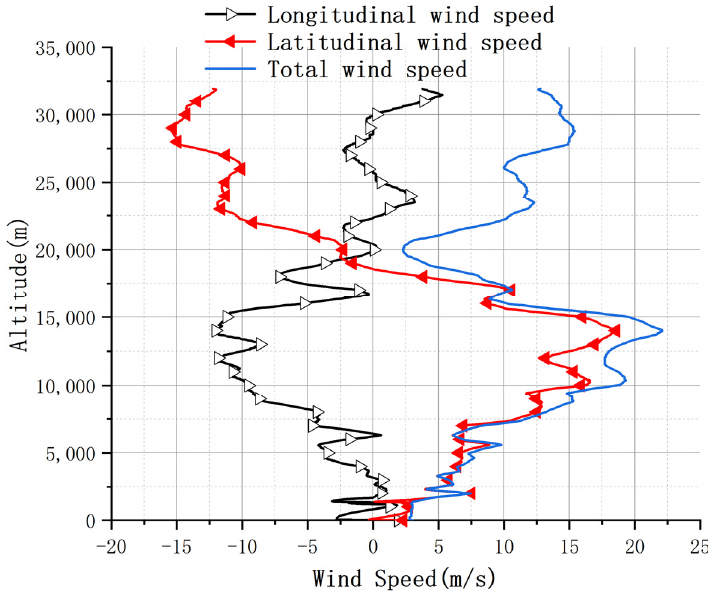
Figure 15. Wind speed profile vs. altitude on launch day.